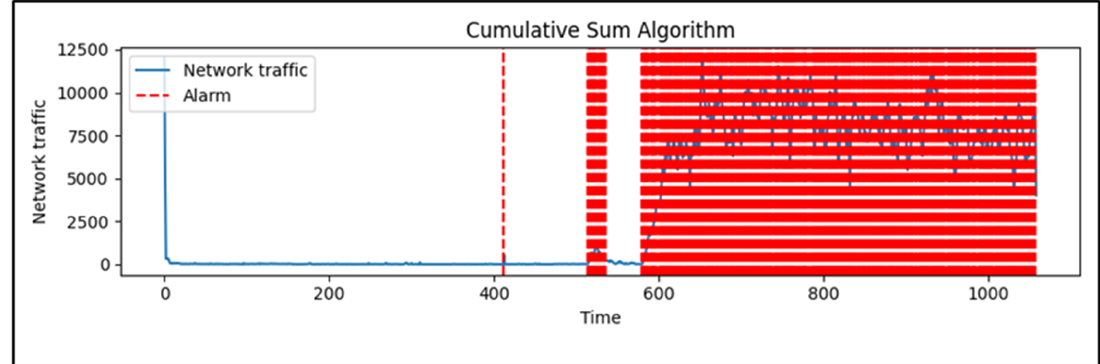
Figure 18. Flooding attack detection by CUSUM.